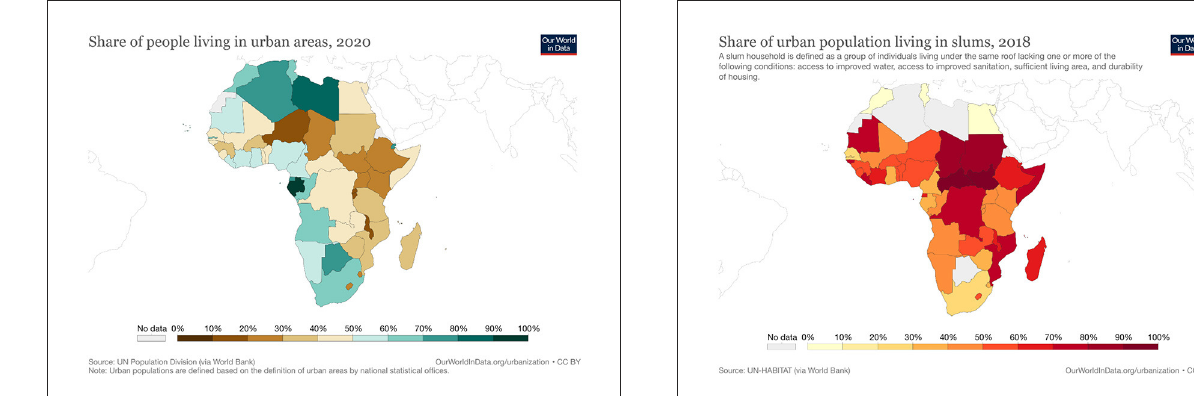
FIGURE1 Share of people living in urban areas, 2020. Source: Ritchie and Roser (2018).